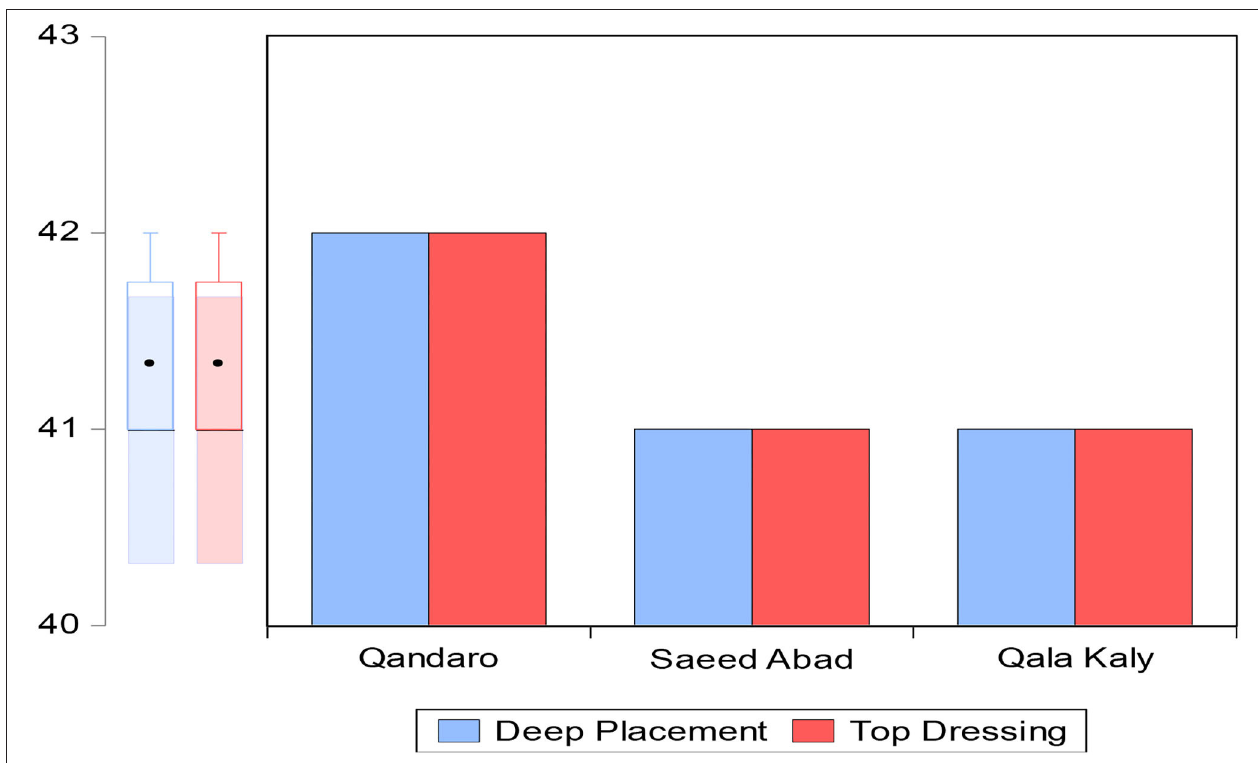
FIGURE 2 | Maize growers observation in district Mardan. Survey data